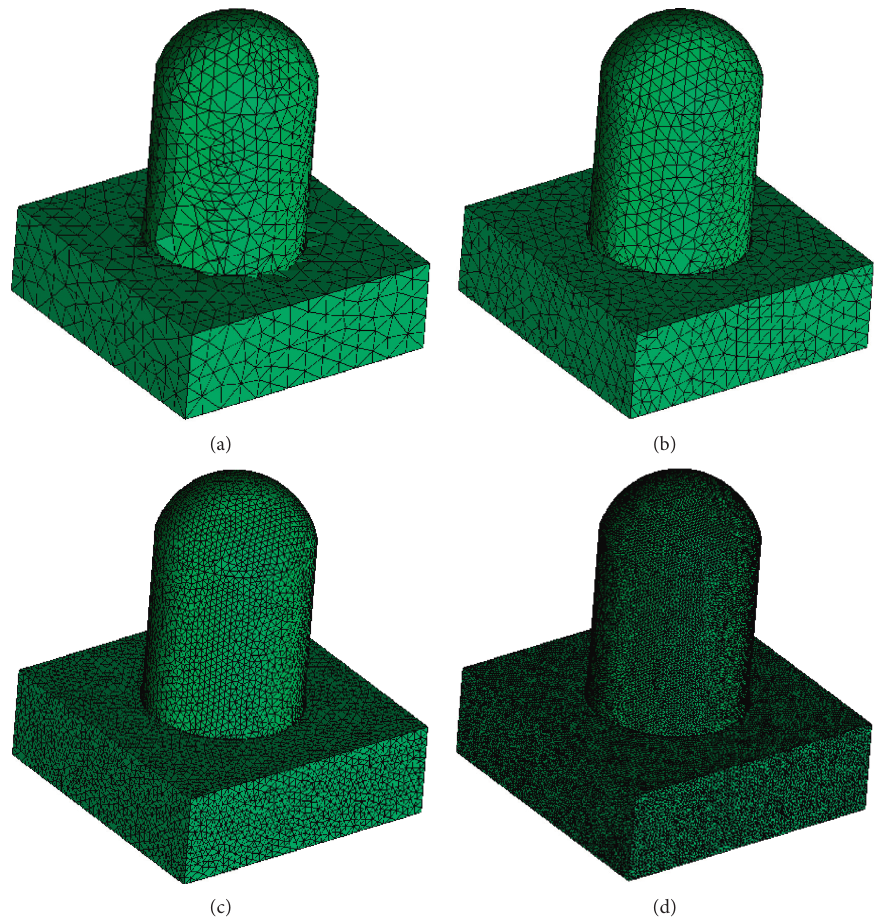
Figure 5: Nuclear containment FE model maximum mesh sizes: (a) 5.5m; (b) 3.5m; (c) 2 m; (d)